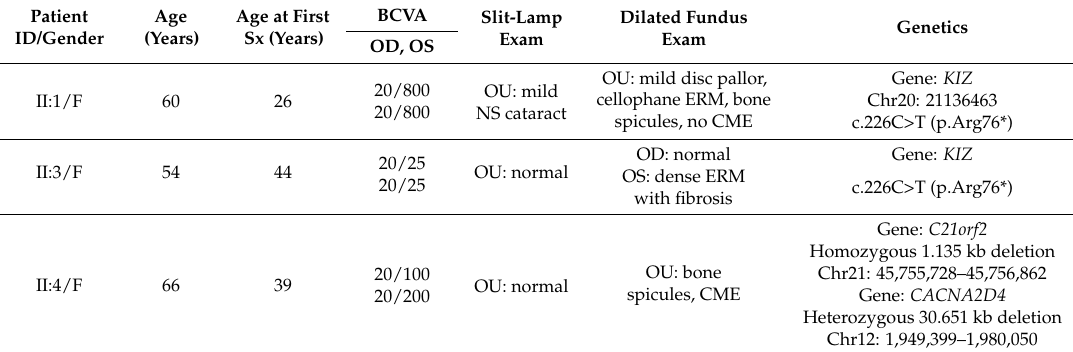
Table 1. Clinical Characteristics.